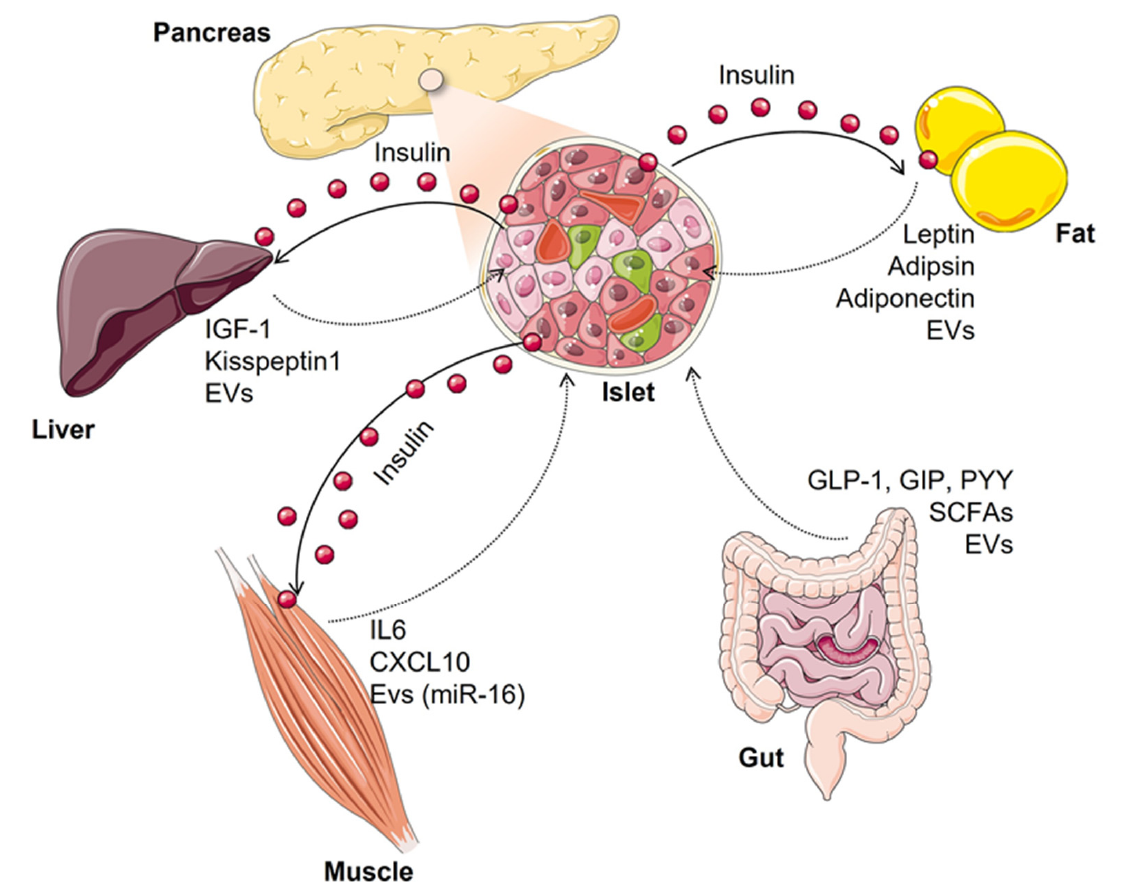
Figure 1. Model of crosstalk between diverse organs and pancreatic beta cells under both physiological and insulin-resistant states. The different factors represented may have the potential to enhance glucose-stimulated insulin secretion or beta-cell proliferation (as IGF-1—insulin-like growth factor-1; GLP-1—glucagon-like peptide-1; kisspeptin1 and SCFAs—short-chain fatty acids) or negatively contribute to reduce functional beta-cell mass during type 2 diabetes progression (as leptin, CXCL10 and EVs—extracellular vesicles—from inflamed adipocytes or insulin-resistant muscle cells). Each pathway is described in more detail along the text.